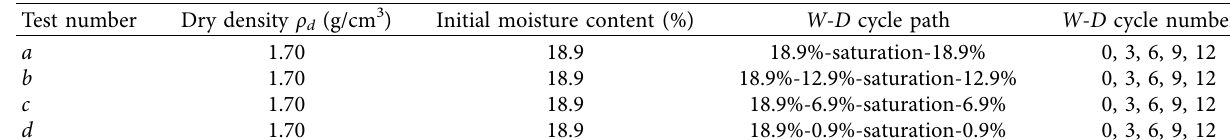
Table 2: W - D cycle scheme of compacted loess.